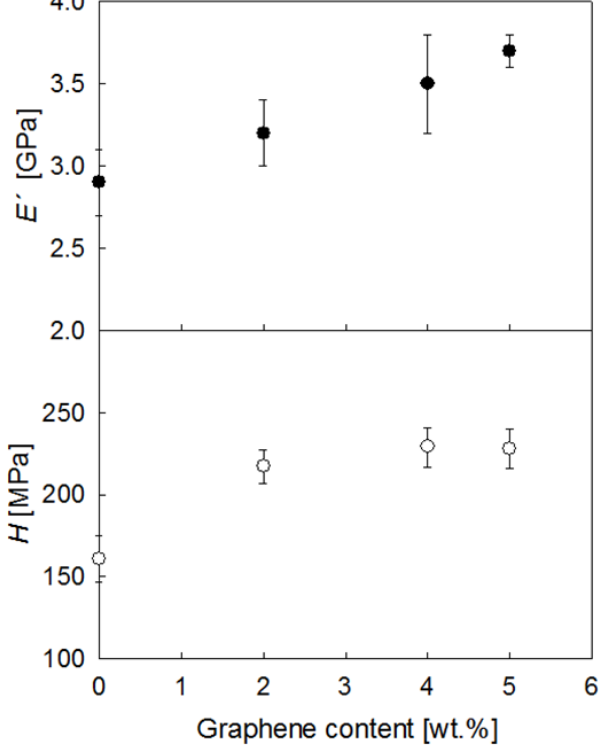
Figure 10. Storage modulus and hardness as a function of graphene content for PET and PET/graphene fibers.